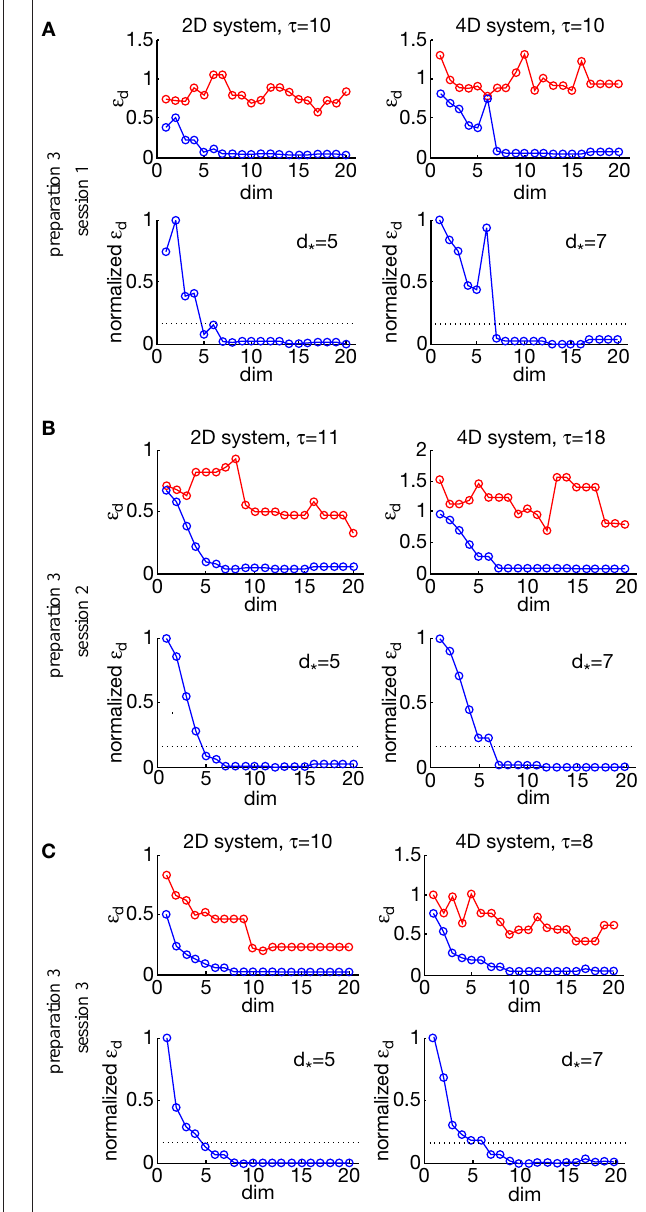
FIGURE 9 | Robustness analysis for the assessed dynamical dimension. In each panel, the columns correspond to different magnitudes of the threshold h (Eq. 17), and the rows correspond to different magnitudes of n (Eq. 15). The three panels in the left column show the assessed dimension, d *, for the data collected using the 2D external system. The three panels in the middle column show the assessed dimension for the data collected using the 4D external system. The three panels in the right column show the difference between the two assessments for each parameter combination. The three panels in each row show the results for a particular preparation, as marked on the left.